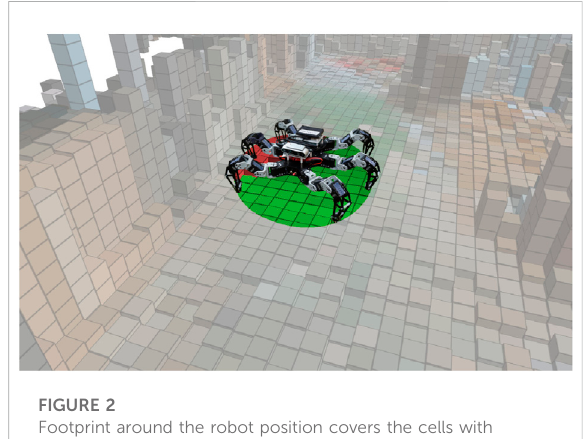
FIGURE 2 Footprint around the robot position covers the cells with potential multi-legged walking robot